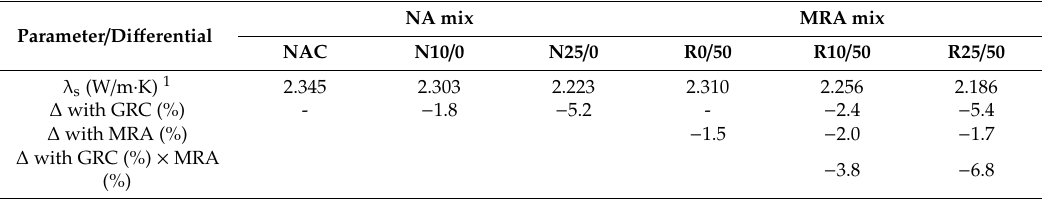
Table 10. Thermal conductivity of the concrete